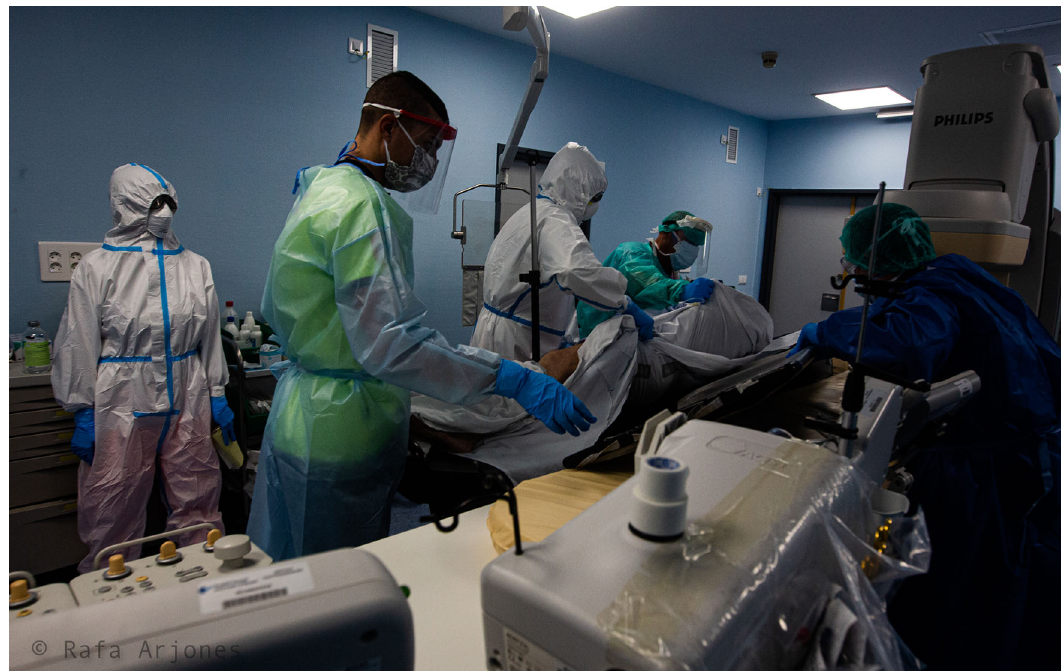
Figure 12.Thepressure onthesocialsystem isincreasing. Lackofknowledge aboutthevirusleadstoanincrease in health measures. This is in addition to the numerous cases of people affected by respiratory problems. In this image, hyper-protective behavior of the healthcare professionals clearly suggests that the patient is infected with COVID-19. This figure has been reproduced with kind permission of the author.